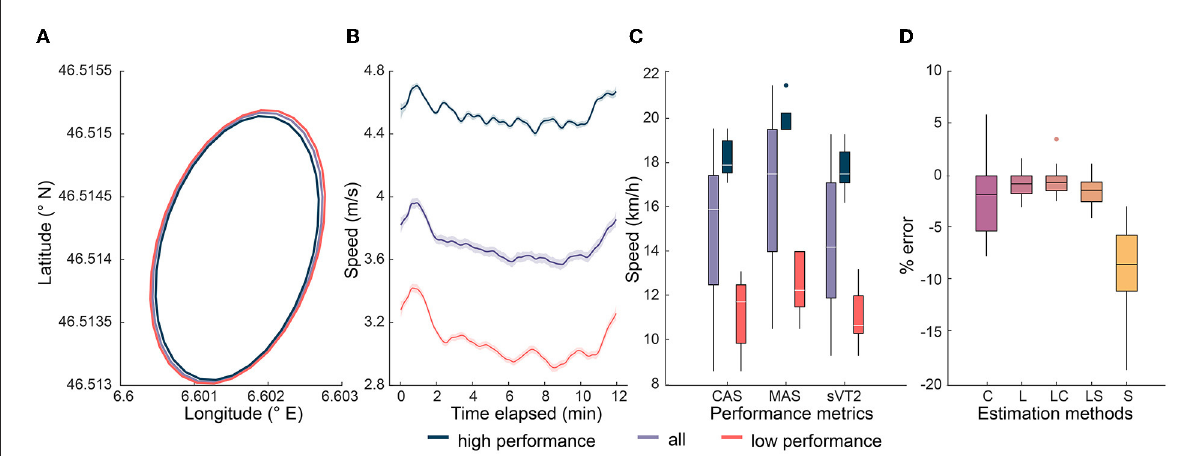
FIGURE5 Performance of participants grouped according to D ref and GNSS tracking. The smoothed mean of original profiles and the 95% confidence interval is shown for easier comprehension of their overall group trend and and plotted using the Gramm toolbox (Morel, 2018). (A) Representative trajectory of the run during the Cooper test. (B) Representative speed profile of the participants during the Cooper test. (C) Xoxplot showing the median and interquartile range of performance across three speed variables. (D) Median and IQR of error in the estimation of distance using five different methods, with C, L, and S corresponding to methods based on Haversine formula with the GNSS coordinates, lap counting, and strapdown integration of ground speed. LC and LS refer to a combination of lap counting with methods based on ground speed and coordinates